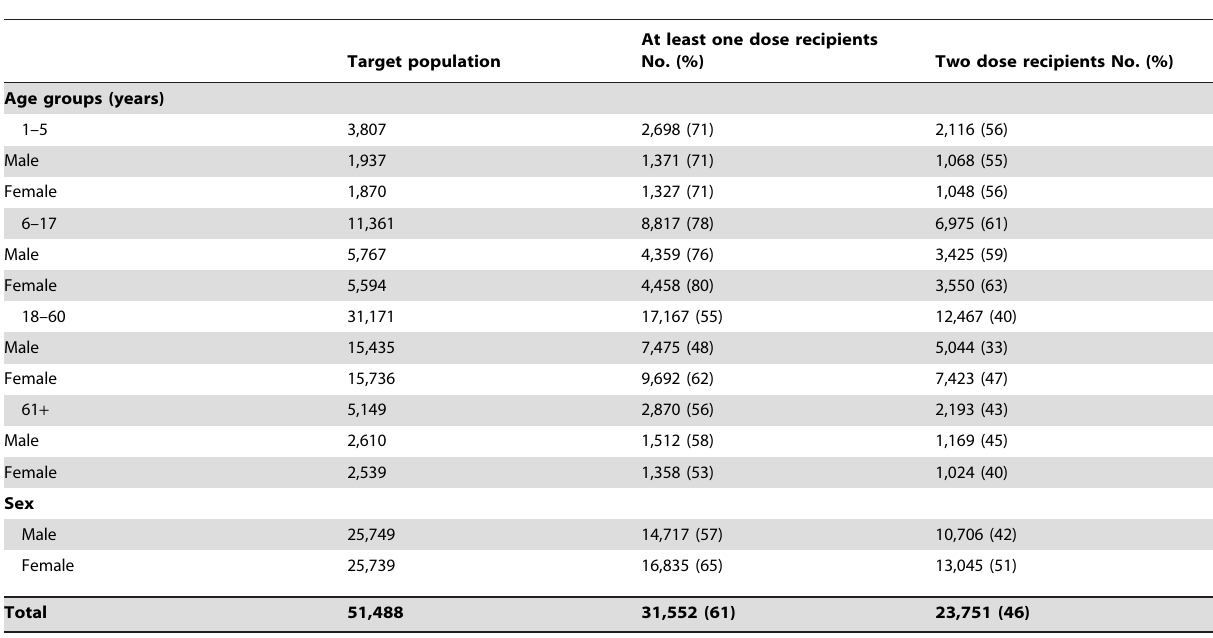
Table 3. Vaccine coverage* by age** groups and sex in Satyabadi block, Odisha, India.